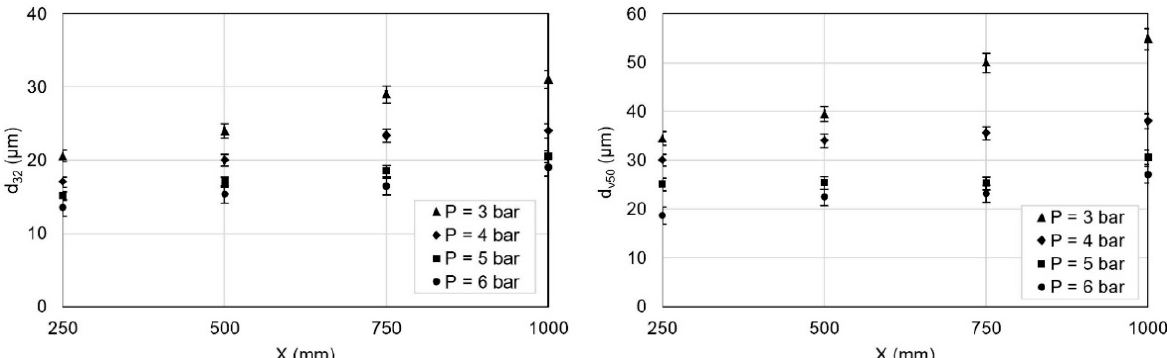
Figure 11. Dependence of droplet diameters d 32 and dv 50 on pressure P at the supply to the nozzle and distance X from the nozzle outlet (for α = − 45°). Table 6. Correlation between d 32 diameter and turbulent flow intensity factor T i.